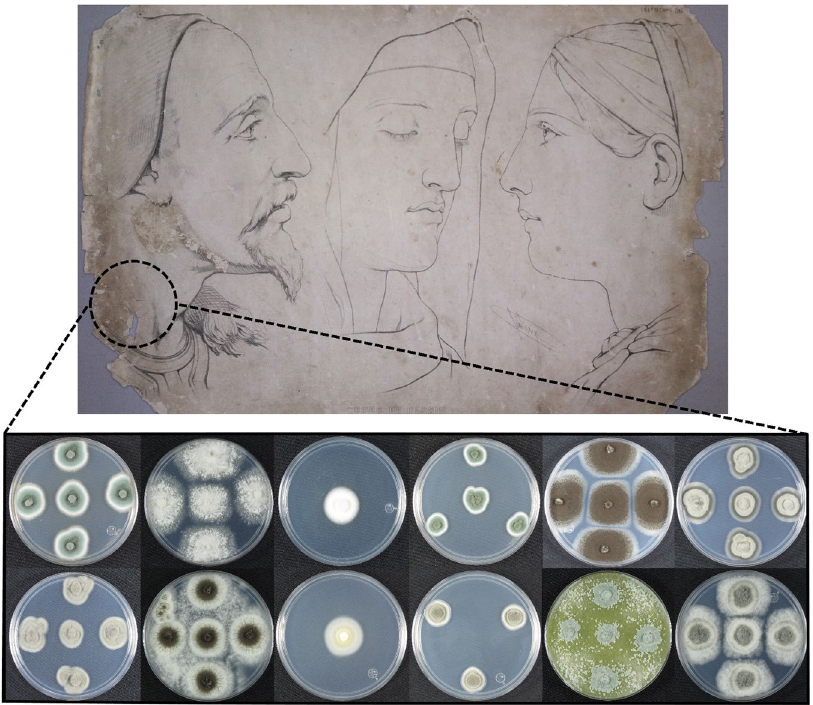
Figure 1. Fungal diversity in ancient lithographs. Several fungi were isolated from stained and degraded areas from nineteenth-century drawing laminae. On the top row from left to right are isolates #5, #10, #19, #9, #8, and #15. On the bottom row from left to right are isolates #16, #22, #21, #11, #23 and #26. Samples in the image were grown in PDA during 6 days. We thank Dr. Salomón Chaves (Instituto de Investigaciones en Arte) for authorizing the use of images from the collection of drawings by Bernard Romain Julien in this